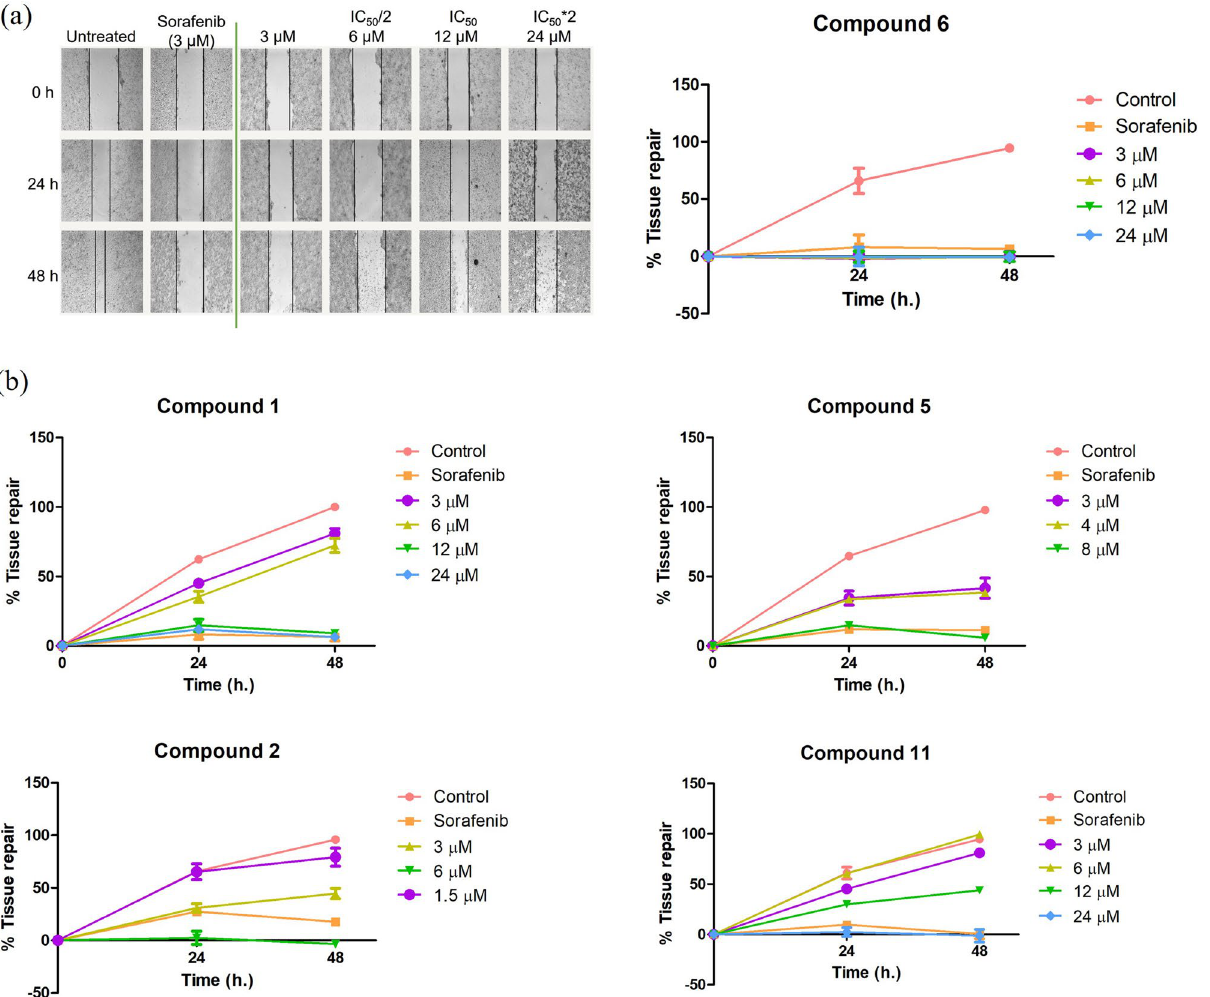
Figure 3. Anti-migration effect of compound 6 ( a ) and compounds 1 , 2 , 5 and 11 ( b